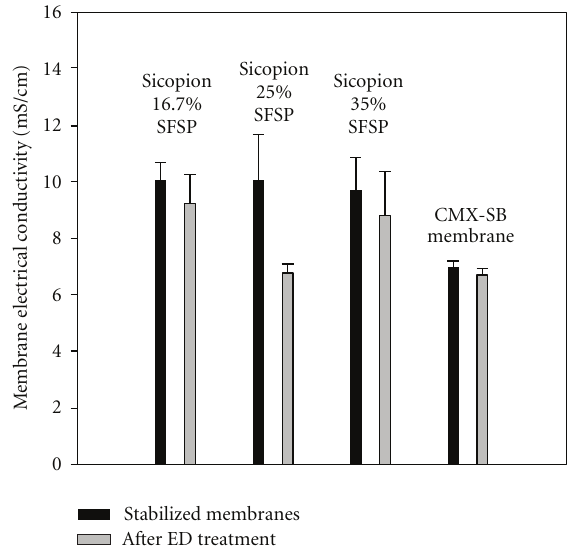
Figure 4: Electrical conductivity of conditioned and used (24h after the ED procedure) Sicopion and CMX-SB membranes.